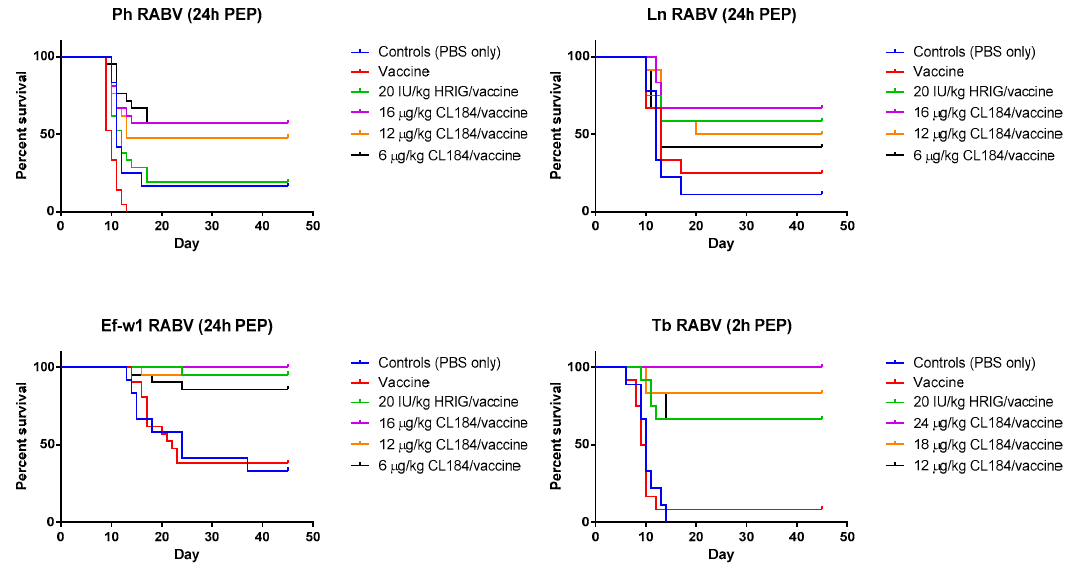
HRIG/vaccine group. (Ph— Parastrellus hesperus , Ef-w1— Eptesicus fuscus western lineage 1, Ln— Lasionycteris noctivagans , Tb— Tadarida brasiliensis North America). ‡ PCECV vaccine was used for Tb group while HDCV for Ef-w1, Ph and WA Ln.